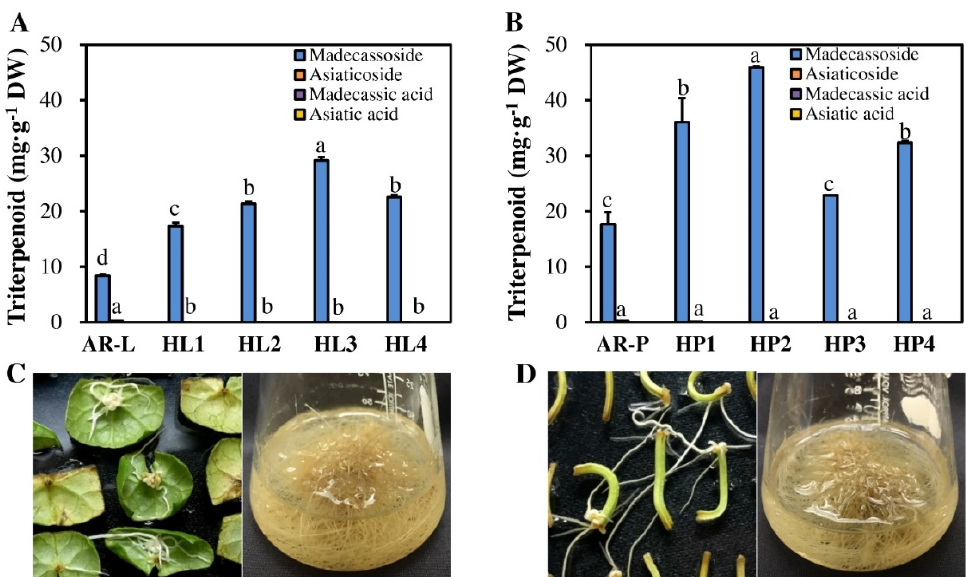
Figure 3. High performance liquid chromatography (HPLC) analysis of triterpenoids in the adventitious root (AR) and hairy root (HR) lines of C. asiatica . ( A ) Triterpenoid contents of AR (AR-L) and HR (HL1-HL4) lines derived from leaves. ( B ) Triterpenoid contents of AR (AR-P) and HR (HP1-HP4) lines derived from petioles. ( C , D ) Photographs showing HR induction from leaves ( C ) and petioles ( D ) as well as HR proliferation. Data represent mean ± SE. Different lowercase letters above bars indicate significant differences (DMRT; p ≤ 0.05).